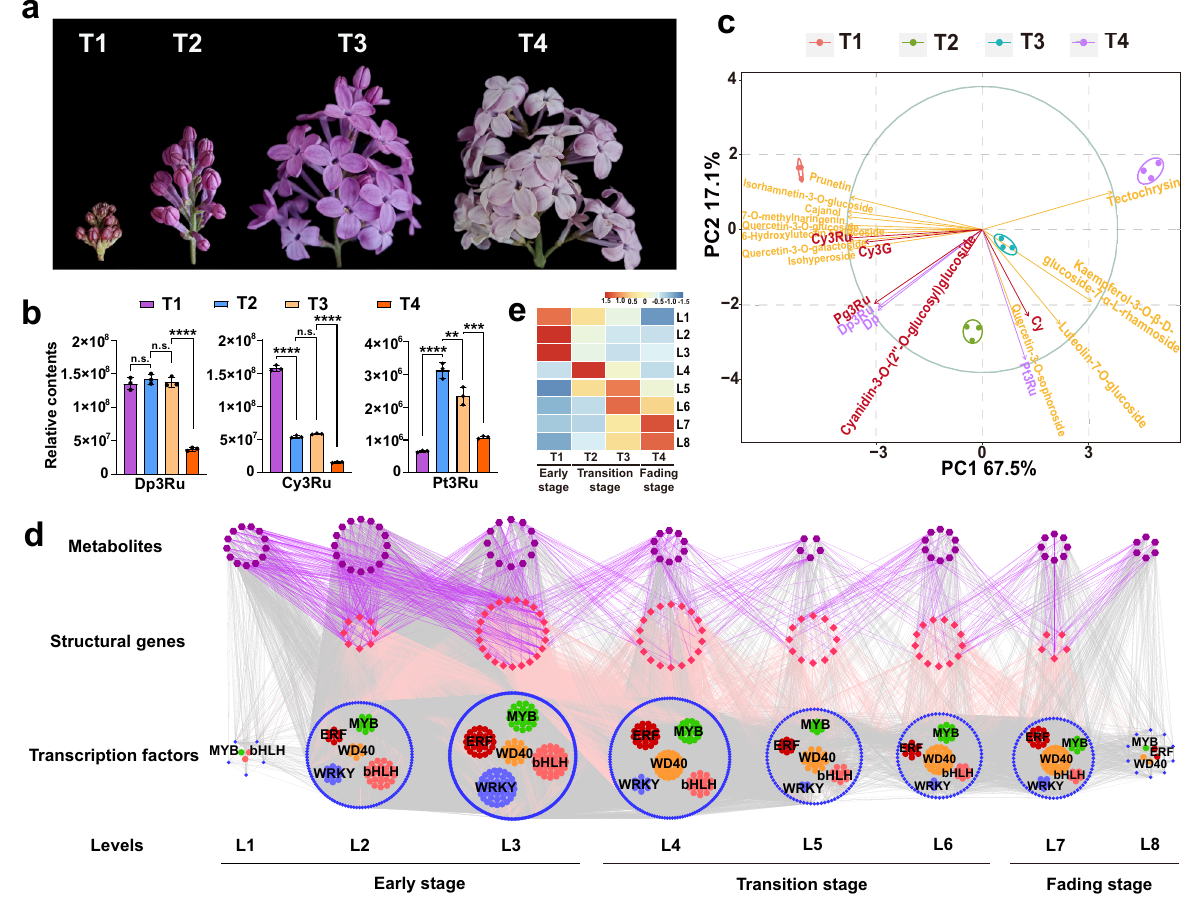
Fig. 4 Principal component analysis and time-ordered gene co-expression network related to fl ower coloring. a Four fl ower opening stages of lilac from T1 to T4 (photographed by Bo Ma in 2021). b Relative contents of main anthocyanins including Dp3Ru, Cy3Ru, and Pt3Ru at the four fl ower opening stages. Data are presented as mean ±SE, n = 3 biologically independent samples (Supplementary Data 2); statistical signi fi cance was calculated by one-way ANOVA with multiple comparisons between adjacent stages, and was indicated by asterisks, in which n.s. (no signi fi cance), p < 0.05 (*), p < 0.01 (**), p < 0.001 (***), and p < 0.0001 (****). c PCA distance biplot. The PCA biplot shows both the PC scores (PC1 and PC2 here) of samples (here: three petal samples for each of the four fl ower opening periods, as dots) and the loadings of variables (here: the relative content of metabolites in each petal sample, as vectors) in the 2-dimension space de fi ned by the fi rst two PCs. We can observe the difference between petal samples at different fl ower opening periods, the relative contribution of metabolite variables to this difference, and the relationship of the difference. d Predicted regulatory network and the connection among metabolites, structural genes of fl avonoids (Fig. 3) and TFs. The purple dots on the top represent metabolites; the pink dots in the middle represent structural genes in the fl avonoid metabolic pathway (Fig. 3); at the bottom, inside the blue circle, the green dots represent the MYB genes, the red dots represent the ERF genes, the orange dots represent the WD40 genes, the pink dots represent the bHLH genes, the blue dots represent the WRKY genes; and outside of the circle, blue dots represent the remaining TFs. L1 to L8 indicate the levels identi fi ed in the time-ordered gene co-expression network. The PCC value increases from small to large, the width of the edges changes from thinner to thicker in the networks. e the heatmaps of average normalized FPKMs for each fl ower opening periods at each level identi fi ed in the time-ordered gene co-expression network. The three stages of fl ower color change are determined based on the gene expression pro fi le and metabolome, as early stage (T1, red-purple), transition stages (T2-T3, violet), and fading stage (T4, light violet nearly (4.49%); 4 quercetin-based fl avonoids, isorhamnetin-3-O-rutinoside (3.66%), isohyperoside (3.03%), quercetin-3-O-xylosyl(1 → 2)gluco- side (2.73%), and quercetin-3-O-galactoside (2.57%) (Supplemen- tary Fig. 10; Supplementary data 1). For the top 5 metabolites (Fig. 3), except for kaempferol-3-O-rutinoside, the contents of remaining 4 metabolites yielded the lowest values at T4 (Supple- mentary Fig. 10), consistent with fl ower color changes as seen with phenotypic observation (Fig. 4a). The latter three fl avonoids (kaempferol-3-O-rutinoside, kaempferol-4-O-glucoside, and kaempferol-3-O-glucoside) determined the pure yellow fl ower color, and showed an overall trend of fi rst increasing and then decreasing, all of which reached the highest contents at T2 (Supplementary Fig. 10).